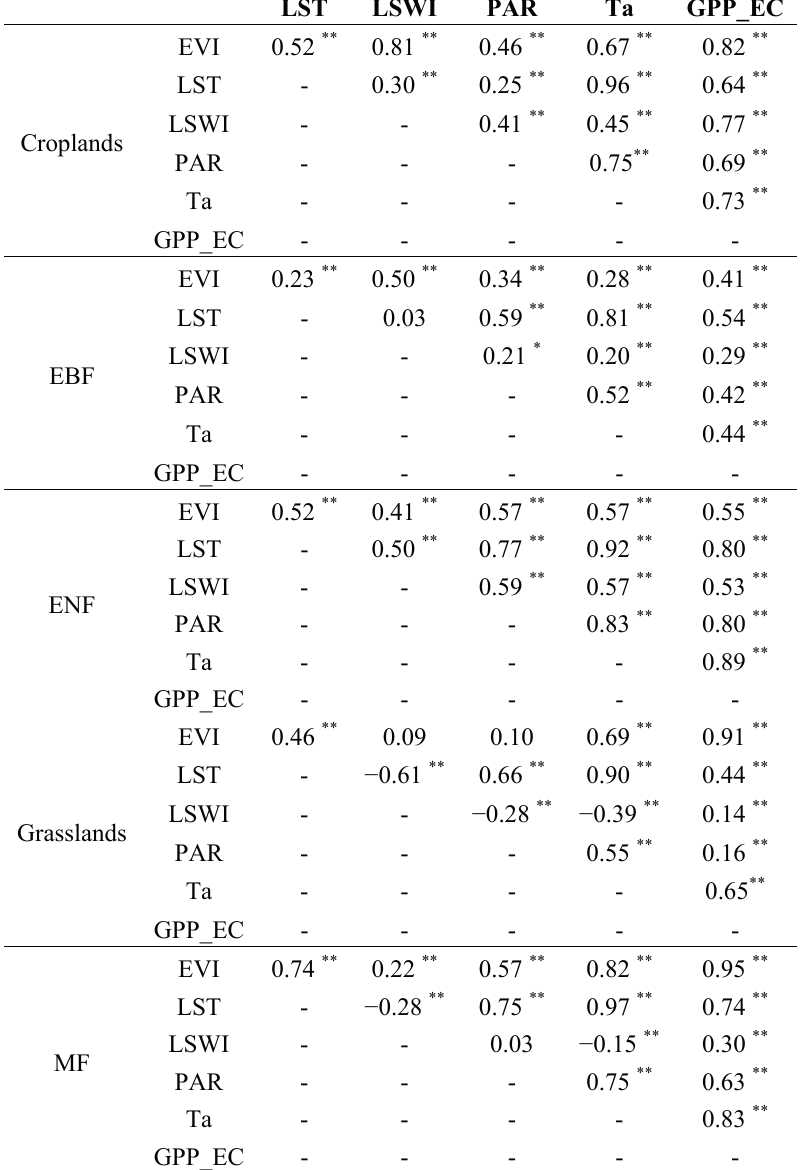
Table 6. The correlation coefficient (r) values between various factors, including EVI, LST, LSWI, PAR, air temperature (Ta), and